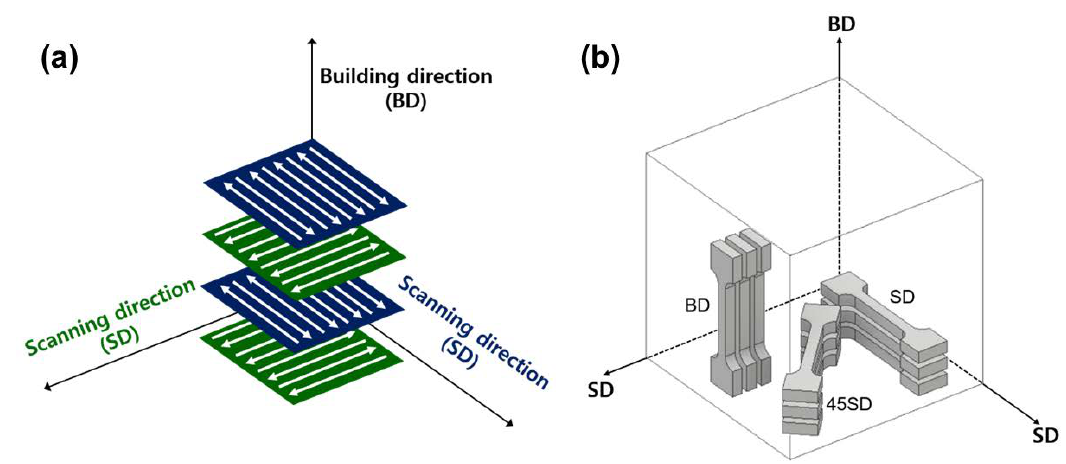
Figure 2. Schematics of ( a ) laser scanning strategy and ( b ) sample building direction (BD) for selective laser melting of maraging steel samples.